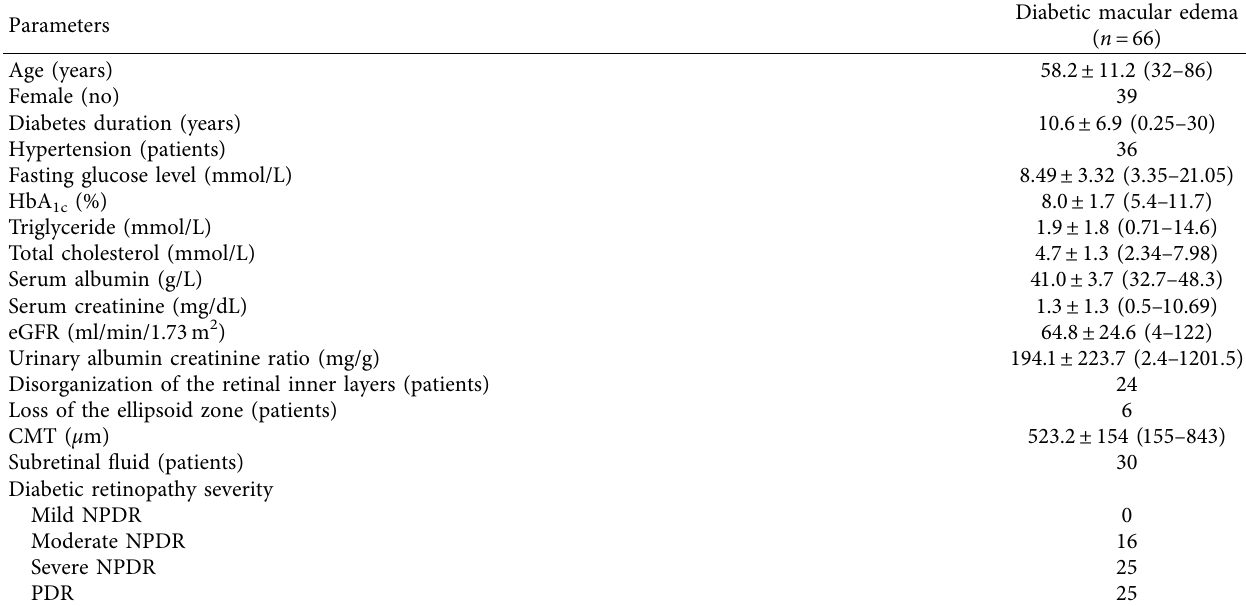
Table 1: Baseline clinical parameters of diabetic macular